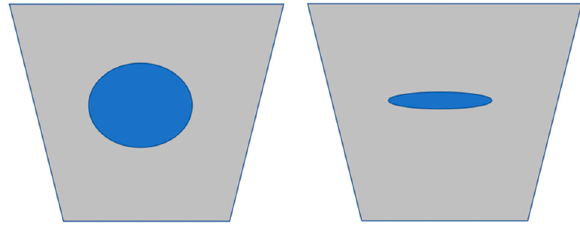
Figure 9. Cross section of two RPT samples with the same bifilm index but a different volume of pores.